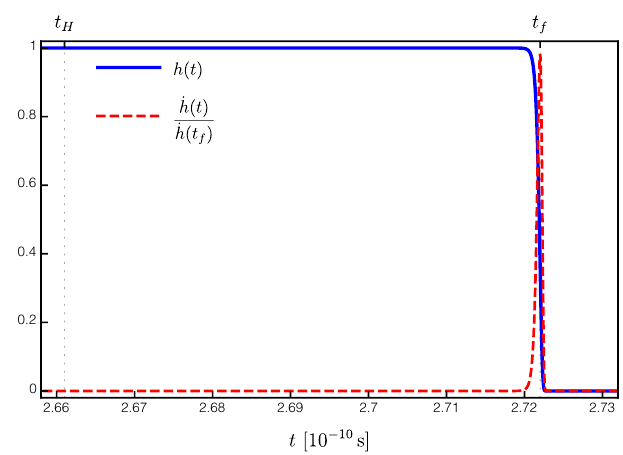
Figure 11: The time-evolution of the fractional volume in the metastable ground state, h , (solid blue) and its derivative ˙ h normalized to the maximum value (dashed red) is shown. At the time t the change of the fractional volume is at its maxi- f mum, i.e. the phase transition is very fast in this moment. Shortly after, essentially the entire universe is in the new ground state. The time t is very close before t . H f Their relation depends on the values of v , β and H . To draw the plot, we use w = 105.2GeV, β = 8950 H and v = 0.9. Then the phase the realistic values of T H w = 104.9GeV. This choice implies that transition has completed at a temperature T f − t ∼ 10 − 13 t f H